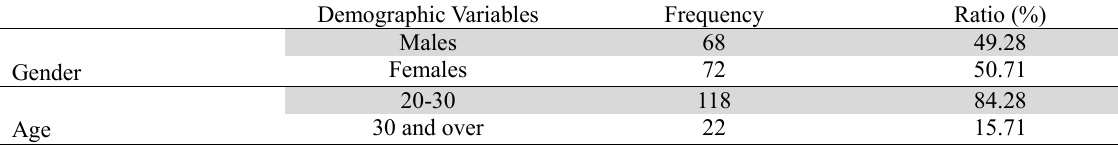
Description of the respondents